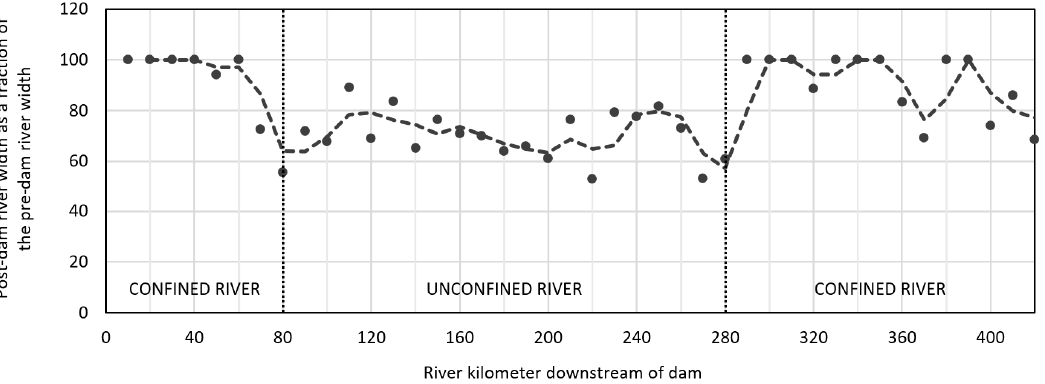
Figure 6. Post-dam river narrowing along the Tekeze River: − 7% in the confined areas versus − 31% in the unconfined areas (dashed line = 20 km-moving average).